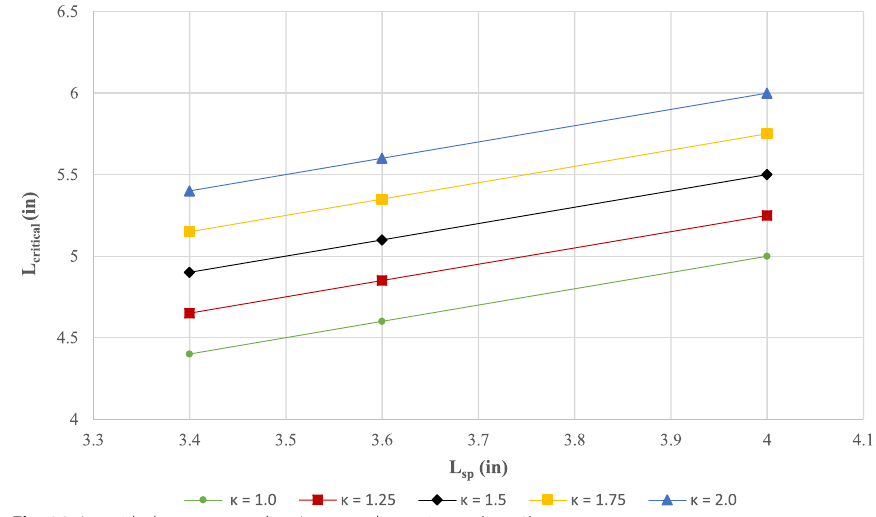
Fig. 20 L sp with the corresponding L critical and at various κ (1 to